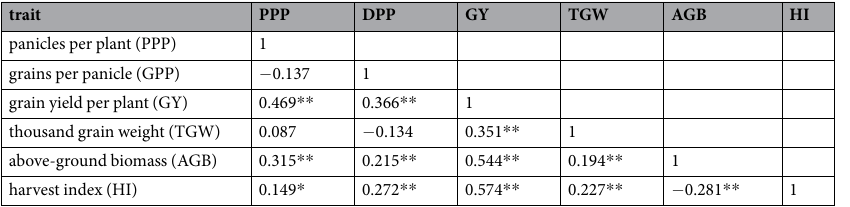
Table 3. Correlation coefficients (r) among yield traits in the RILs population derived from the cross of R998 × Francis. Note: * and ** indicate significant difference at the 0.05 and 0.01 level,